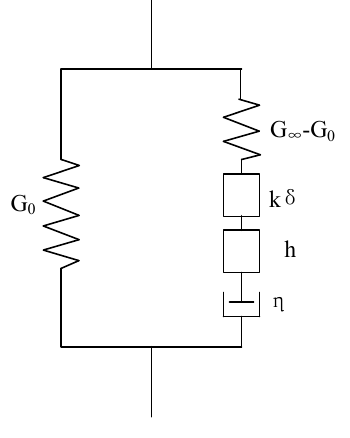
Figure 1. 2S2P1D model.